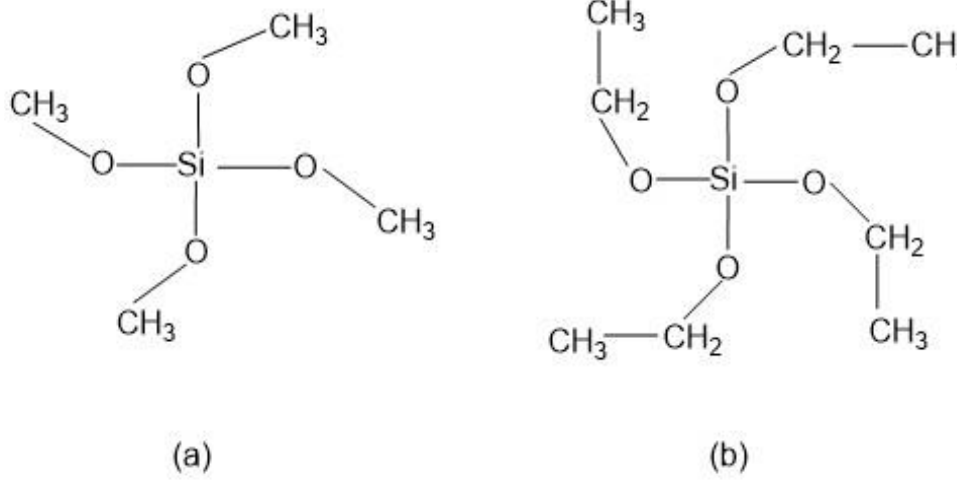
Figure 2. Alkoxysilanes such as ( a ) tetramethoxysilane (TMOS) and ( b ) tetraethoxysilane (TEOS) are extensively used to produce silica gels.